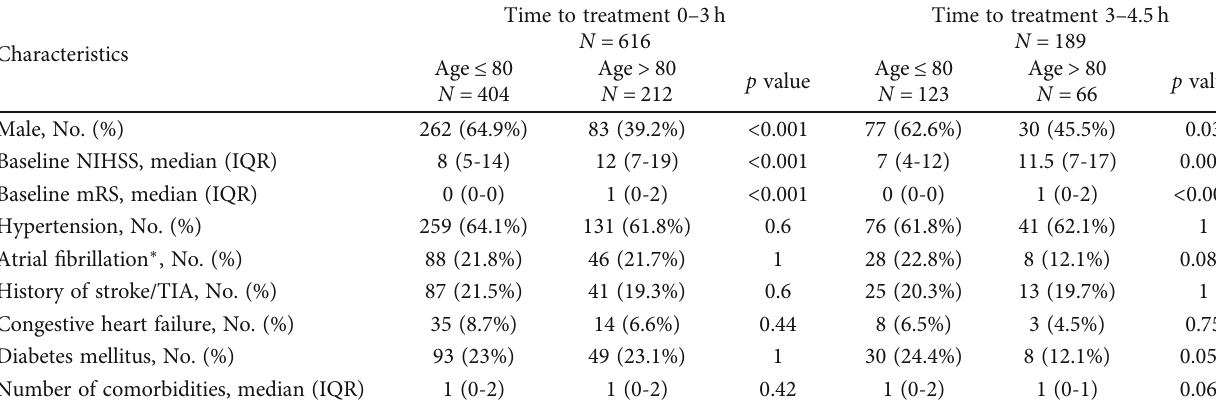
Table 1: Basic characteristics between the groups of aged > 80 and aged ≤ 80 according to treatment window.